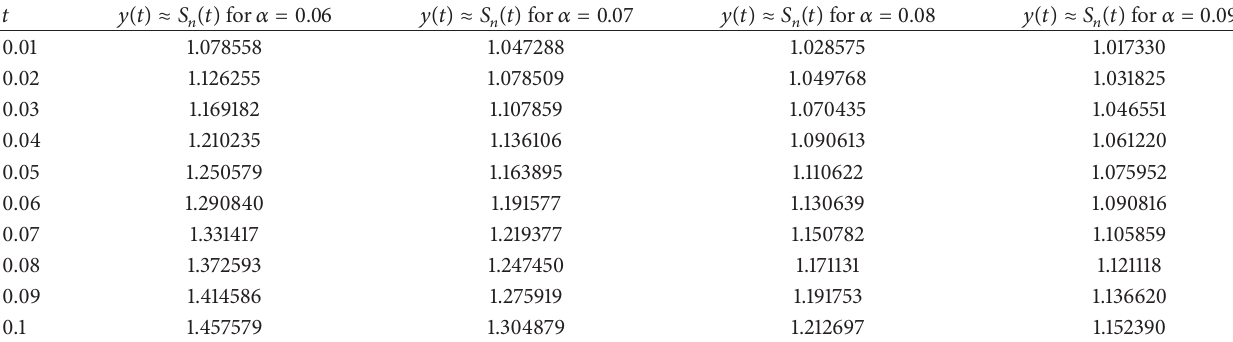
Table 5: Approximate solutions obtained by GTSM in Example 2 for different order of derivatives.